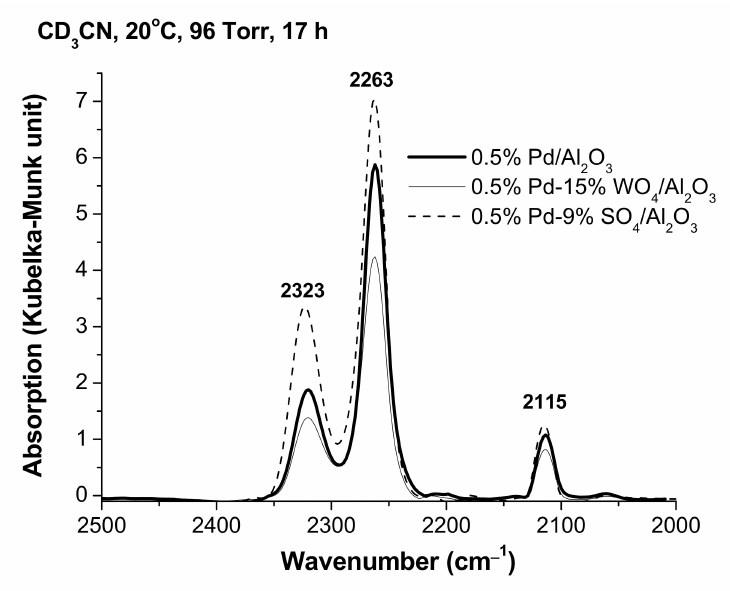
Figure 4. DRIFT spectra of CD 3 CN adsorbed on three